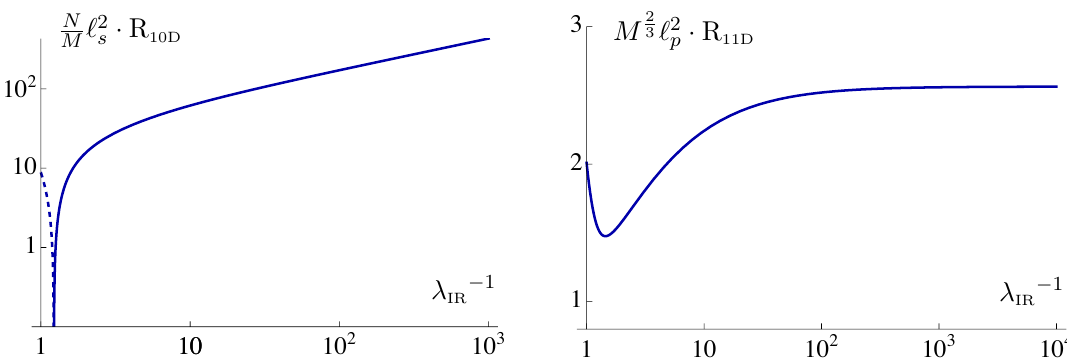
Figure 5. Left : absolute value of the ten-dimensional Ricci scalar evaluated at the origin of the geometry, in string units, as a function of the IR value of the dilaton factor e Λ . The solid curve stands for solutions with negative IR Ricci scalar, whereas for the dashed curve it is positive. Right : eleven-dimensional Ricci scalar evaluated at the origin of the geometry, in Planck units, in terms of the same